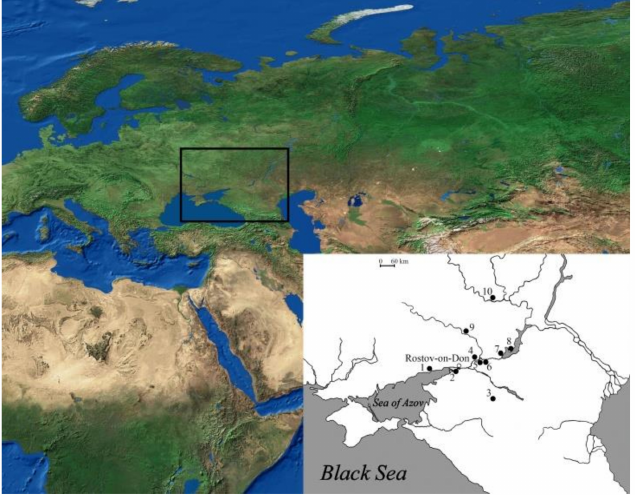
Figure 1. The localities of Mammuthus intermedius remains in the Lower Don Region (Russia).